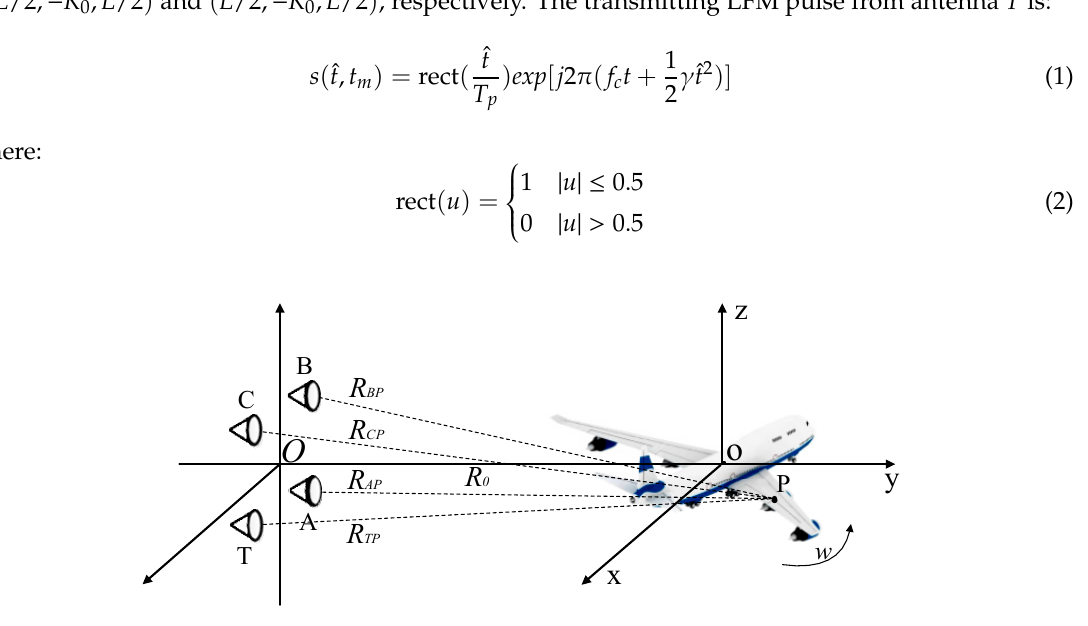
Figure 3. Geometry of InISAR imaging configuration.